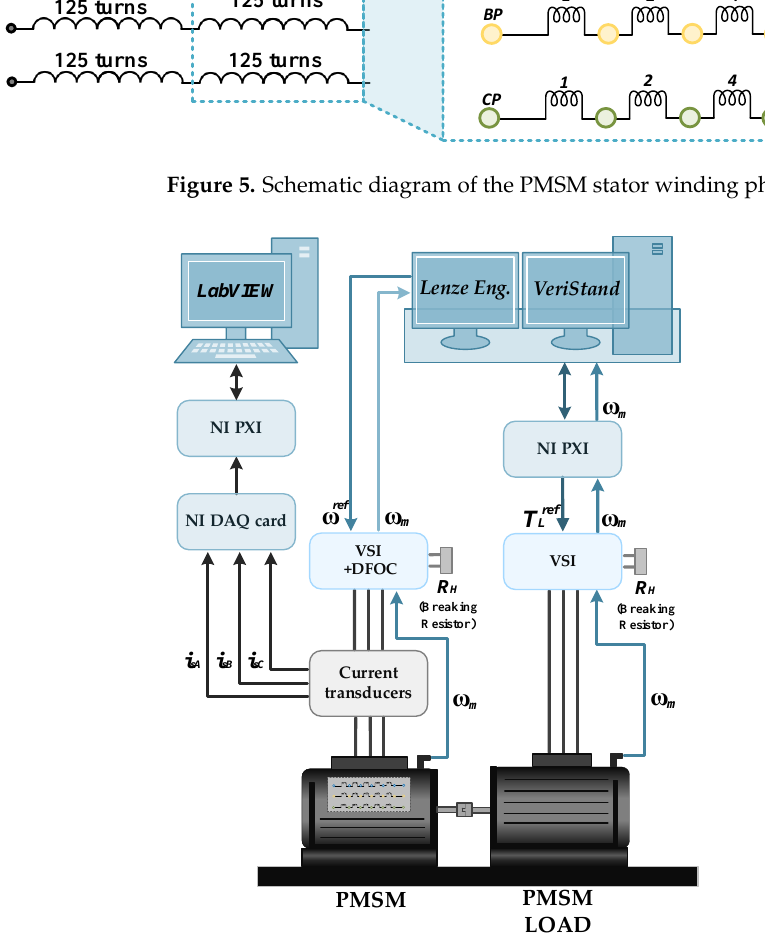
Figure 6. Block diagram of the experimental setup.